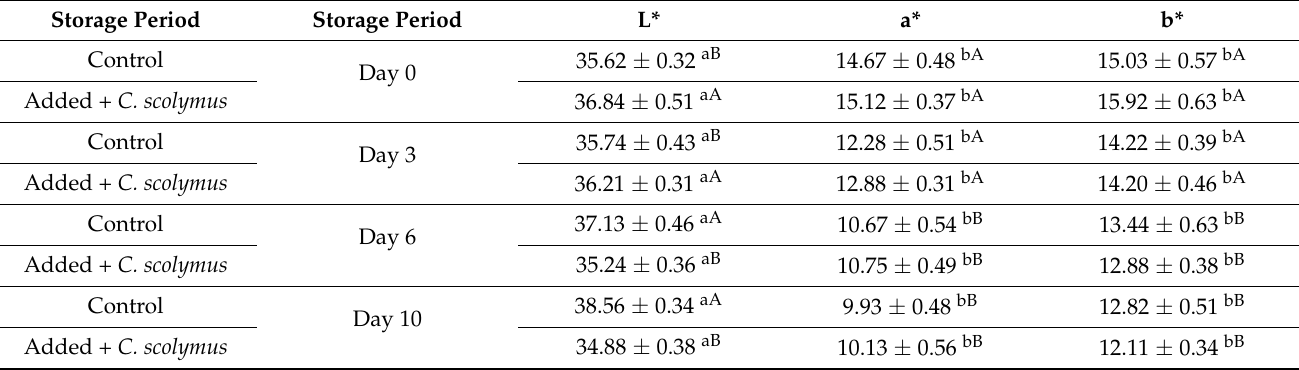
Table 5. Color parameters (L*, a*, b*) of minced meat samples during